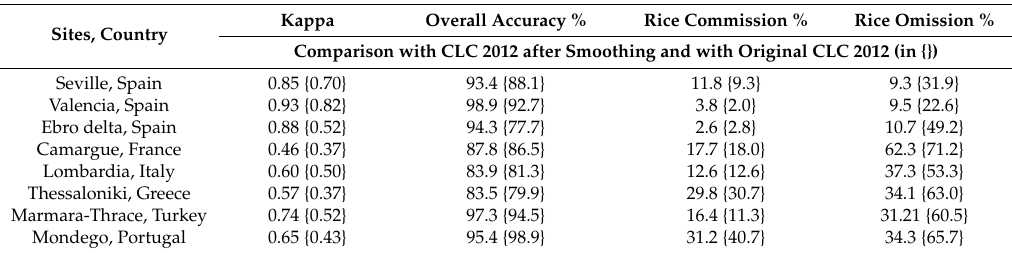
Table 3. Comparisons of rice crop extraction accuracies from time series S-1 data with Corine Land cover products (CLC 2012). Kappa Overall Accuracy % Rice Commission % Rice Omission % Sites, Country Comparison with CLC 2012 after Smoothing and with Original CLC 2012 (in {}) Seville,